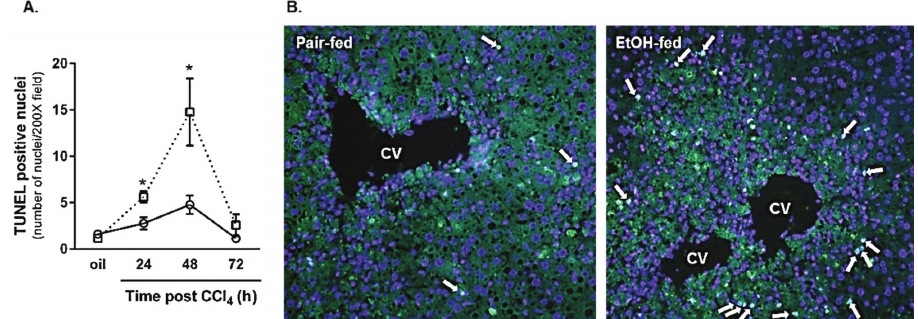
Figure 5. Hepatocyte apoptosis was increased in livers from ethanol-fed mice 24 and 48 h after CCl 4 exposure. The terminal deoxynucleotidyl transferase dUTP nick end